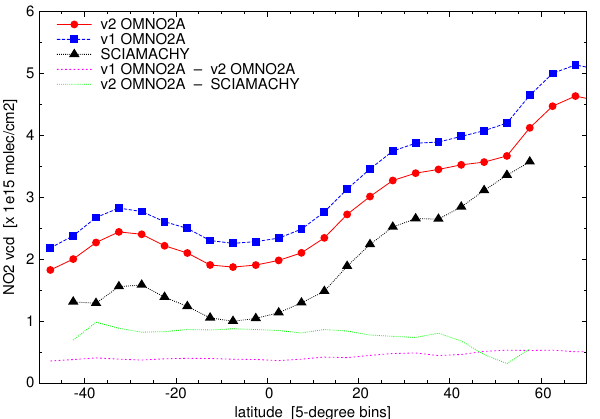
Figure 6. Comparison of the NO 2 VCD values (lines with symbols) Fig.6. ComparisonoftheNO 2 VCDvalues(lineswithsymbols)ofthenewv2OMNO2A(redcircles)andold v1OMNO2A(bluesquares)retrievalforthePacificOceanorbitof1July2005,andtheaverageSCIAMACHY of the new v2 OMNO2A (red circles) and old v1 OMNO2A (blue data (black triangles) over Pacific Ocean of the same day. The two lines without symbols show differences squares) retrieval for the Pacific Ocean orbit of 1 July 2005 and betweentheNO 2 VCDvalues. AcomparisonbetweenOMIandSCIAMACHYshouldbelimitedtolatitudes the average SCIAMACHY data (black triangles) over Pacific Ocean below 45 ◦ ,becauseforhigherlatitudestheinstrumentcoverdifferentgeographicareas. of the same day. The two lines without symbols show differences between the NO 2 VCD values. A comparison between OMI and SCIAMACHY should be limited to latitudes below 45 ◦ , because for higher latitudes the instruments cover different geographic areas.